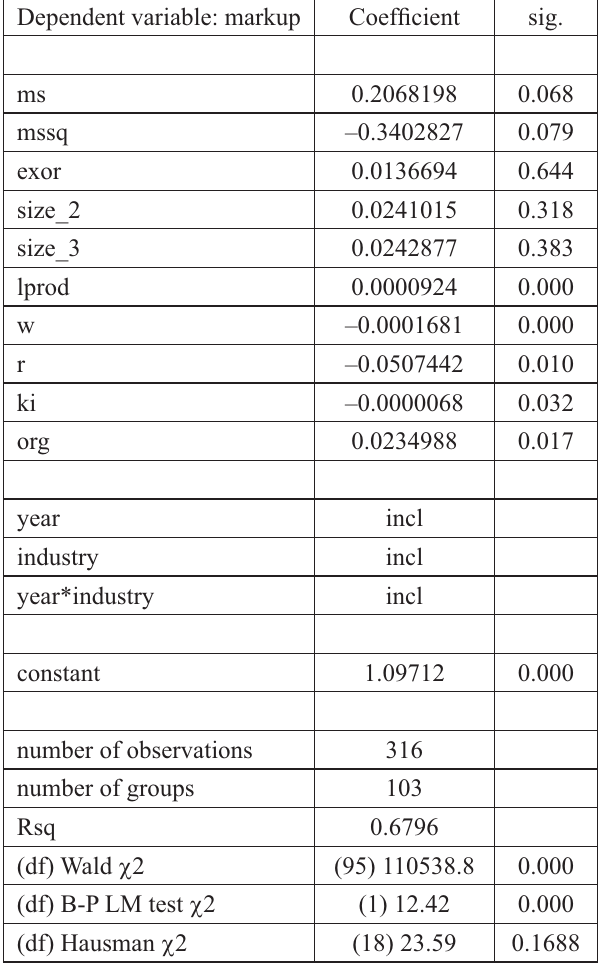
Table 3. Random effects GLS regression